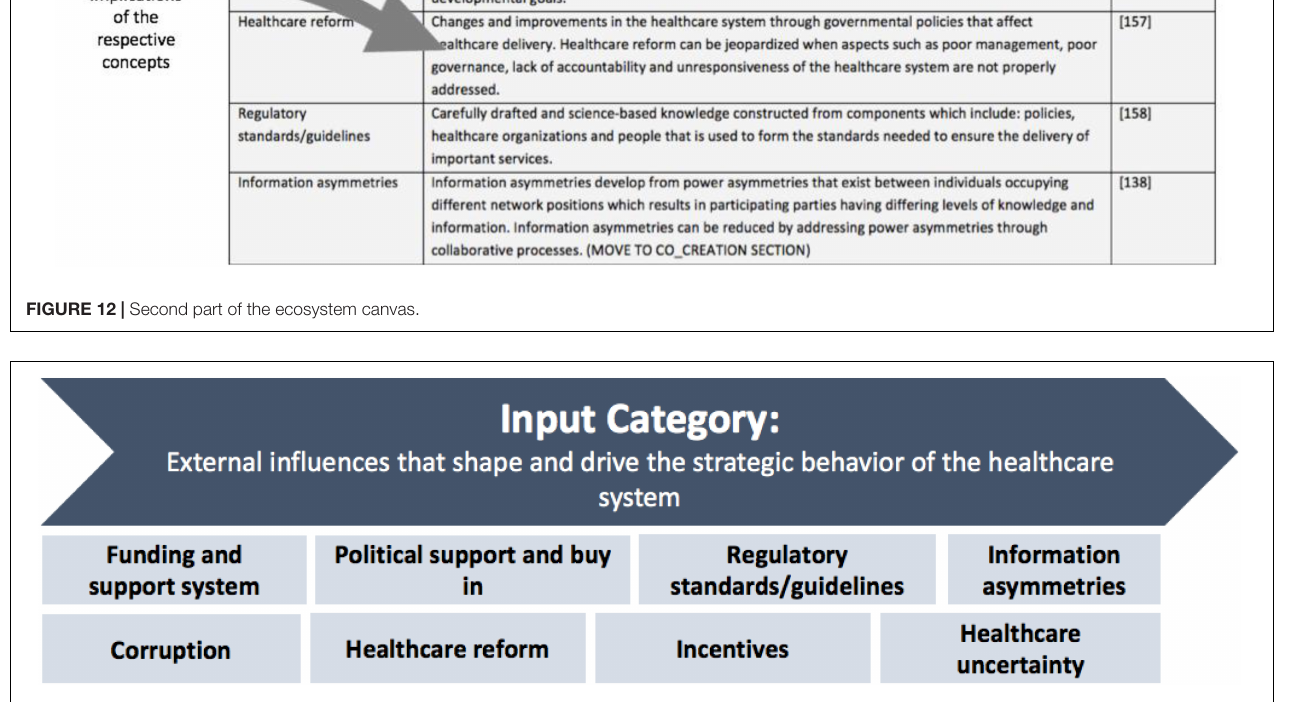
FIGURE 13 | Recommended external influences